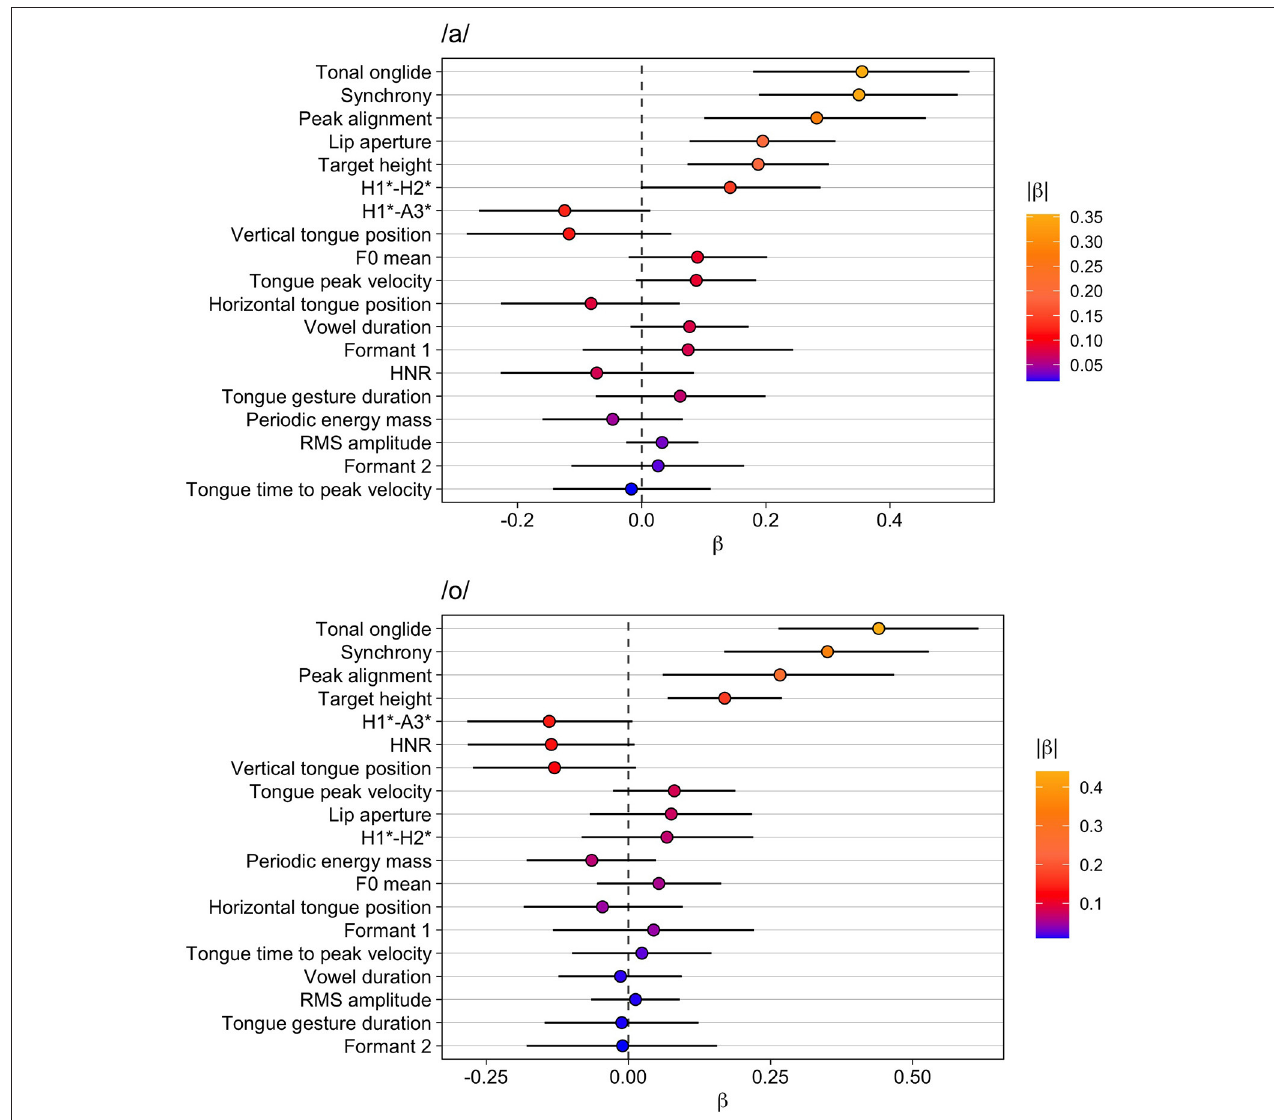
FIGURE 5 | Modeling results for narrow vs. contrastive focus. Top: vowel /a/, bottom: vowel /o/. The whiskers indicate the 90% Credible Interval.